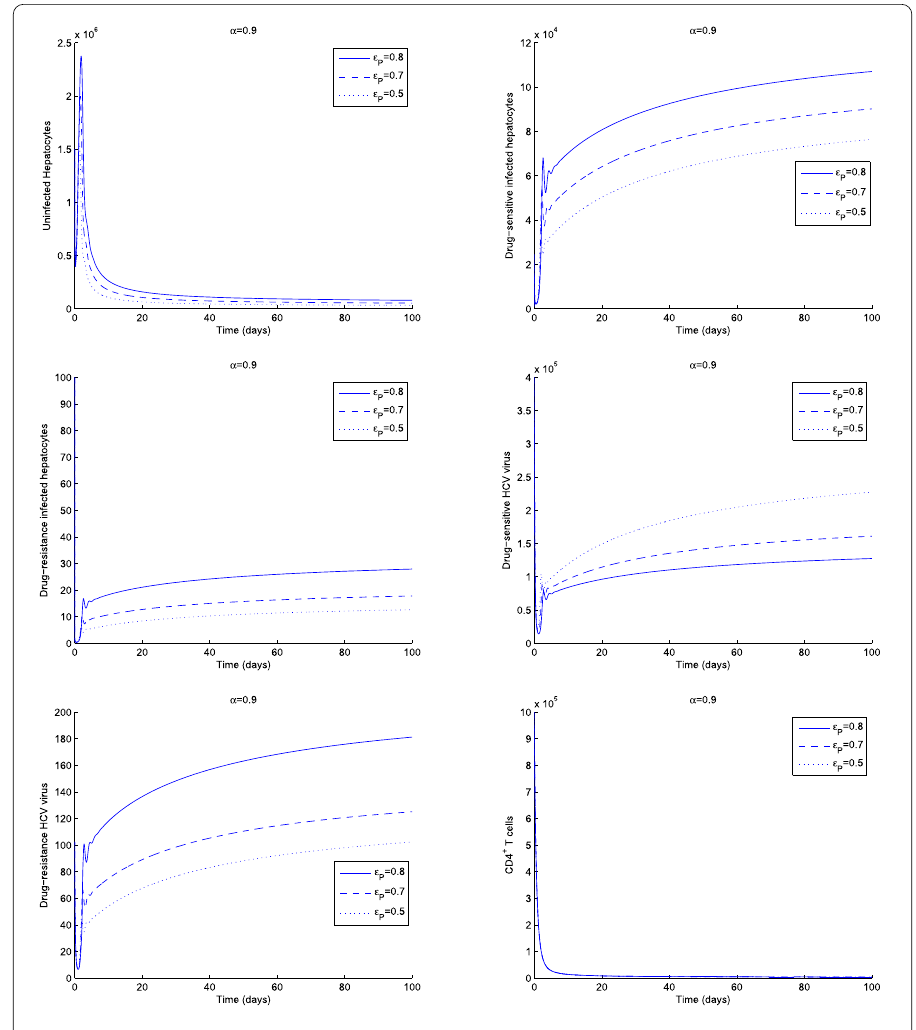
Figure 6 Dynamics of the variables of system (1) for different values of (cid:3) P , the protease inhibitor drug efficacy, and α = 0.9. Parameter values are in Table 1 and initial conditions are given in the